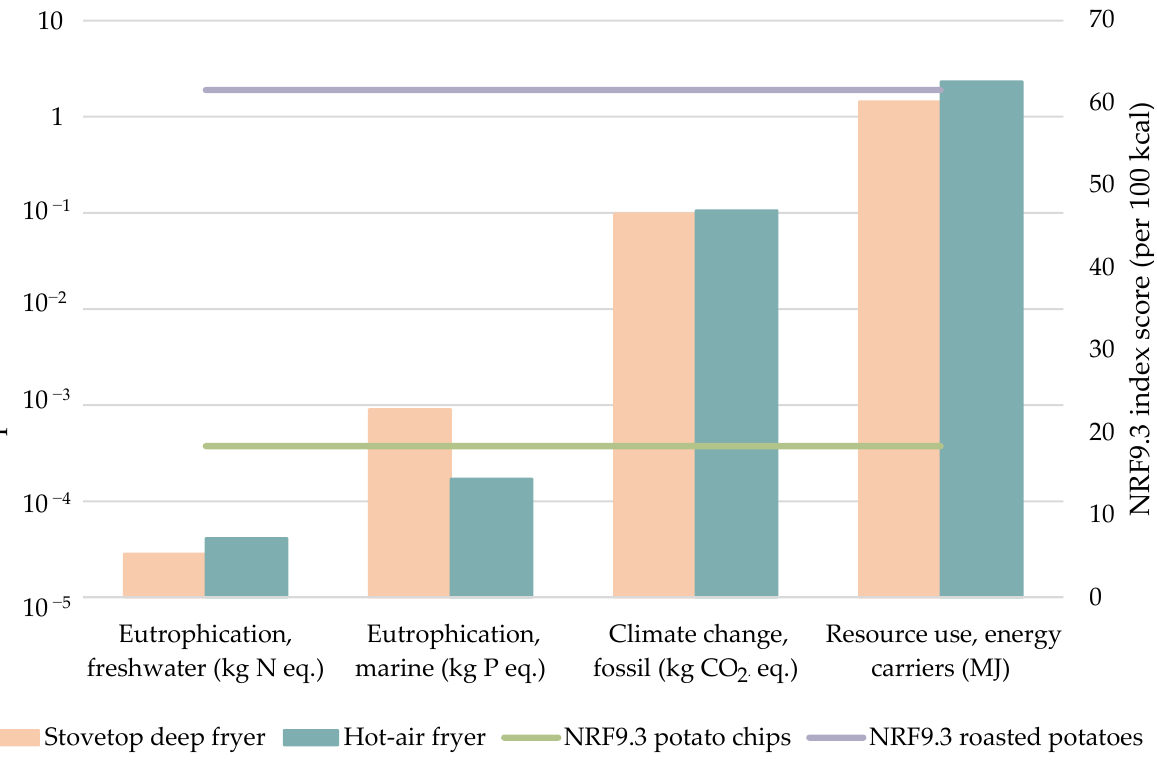
Figure 8. Comparison of two different frying techniques in terms of water, energy, and food indicators. Bars represent the environmental impact, while horizontal lines show the NRF9.3 score of each final product.